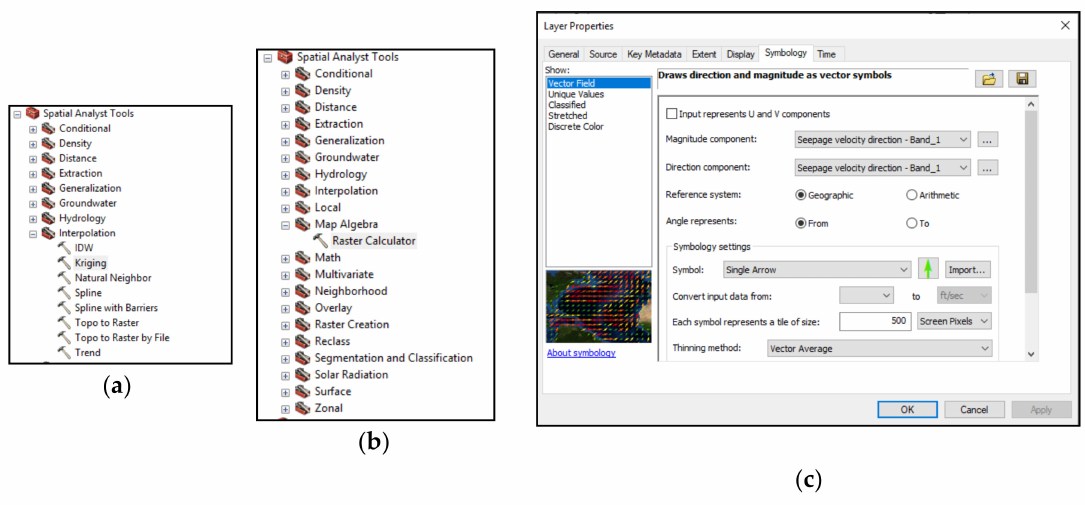
Figure 7. Additional tools and settings used: ( a ) interpolation tool, kriging type; ( b ) Map Algebra / Raster Calculator; ( c ) settings window for Darcy velocity direction map